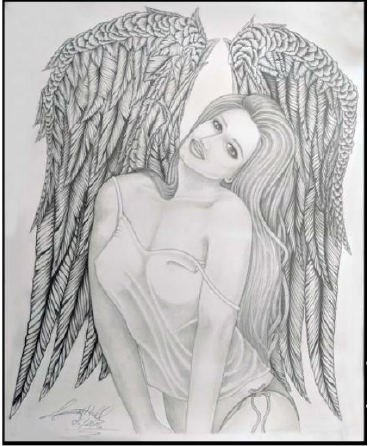
Figure 4: Graphite drawing by JH (2018: